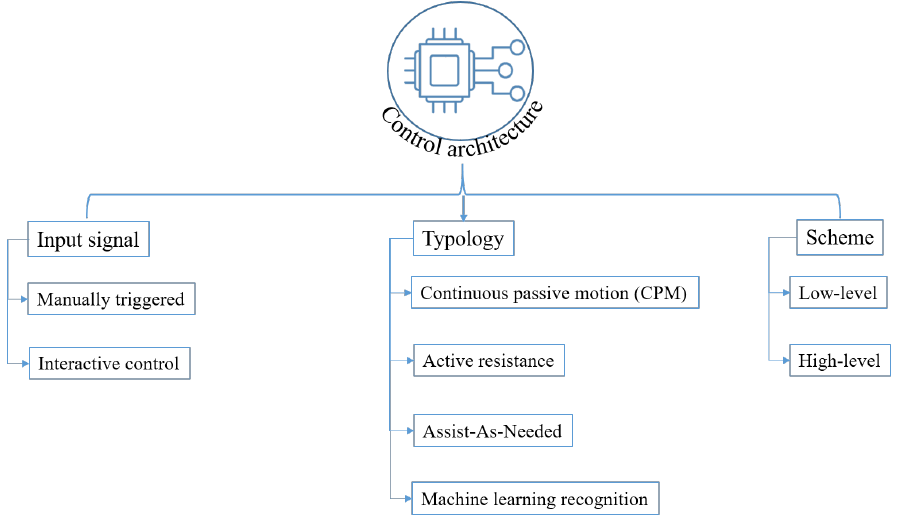
Figure 24. Different control signals, control paradigms, and control schemes adopted in different designs. Different types of control paradigms have been explored to address different